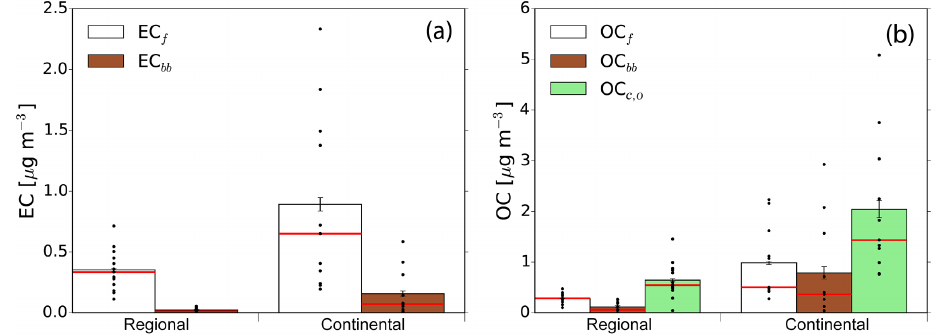
Figure 6. Concentrations of different subfractions of OC and EC from various sources in the time period from February 2011 to march 2012 averaged for regional and continental air mass origin. The bars show the average concentrations and the error bars the propagated uncertainties from the Monte Carlo simulations. The red line shows the median concentration. The individual data points are shown as black dots. (a) EC from fossil-dominated sources (EC f ) and from biomass combustion (EC bb ) ; (b) OC from fossil-dominated sources (OC f ) , biomass combustion (OC bb ) , and biogenic sources (OC c , o ) .